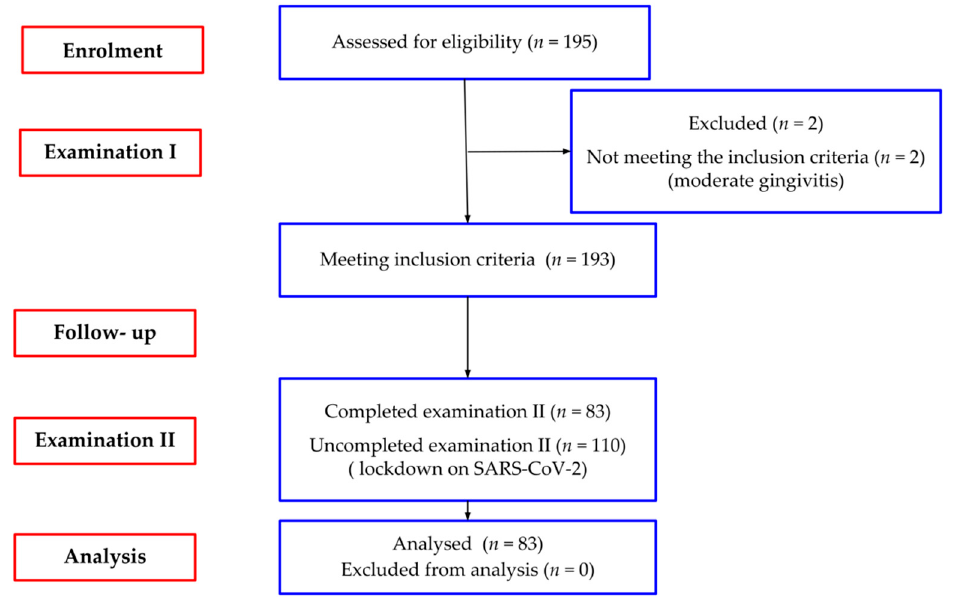
Figure 1. Study flow chart ( n —number of participants).